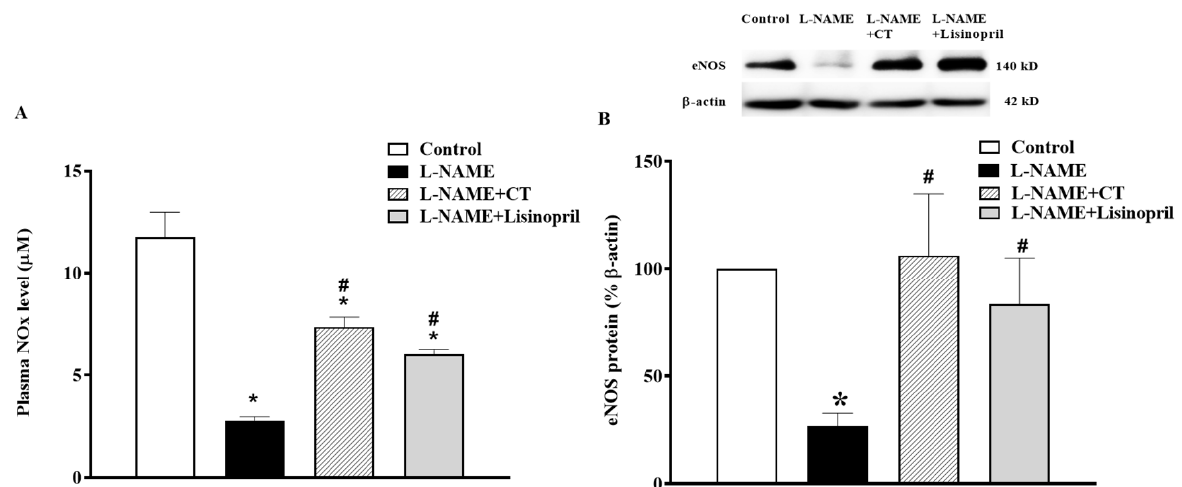
Figure 5. Effects of CT extract and lisinopril on nitric oxide metabolites ( A ) and endothelial nitric oxide synthase (eNOS) protein expressions ( B ) in cardiac tissue of all groups in the experiment. Data are expressed as mean ± SEM ( n = 4/group), * p < 0.05 vs. control, # p < 0.05 vs. L-NAME, CT: Clitoria ternatea Linn. extract.